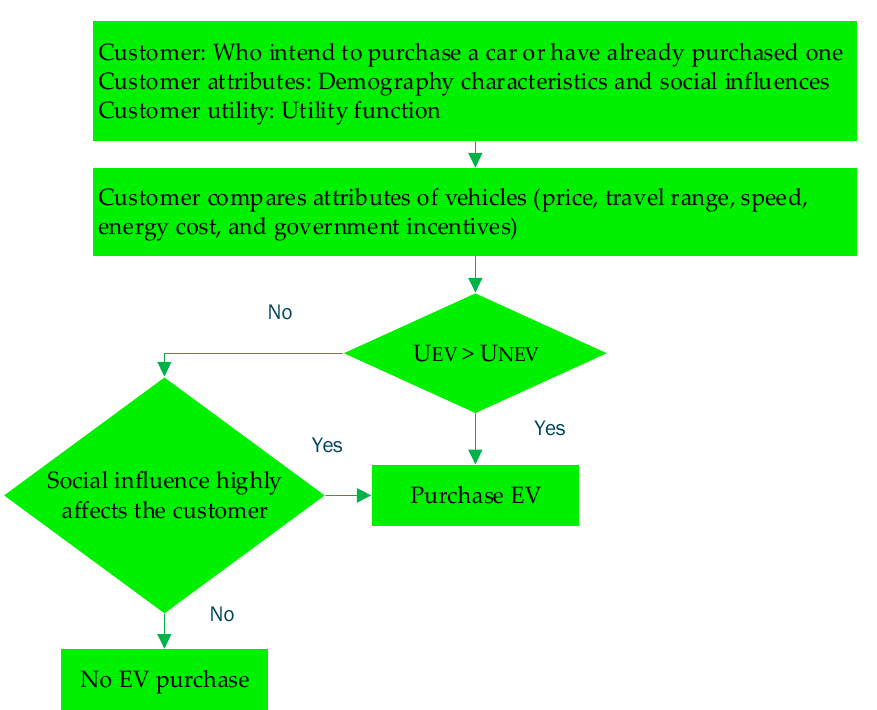
Figure 3. Vehicle choice algorithm.